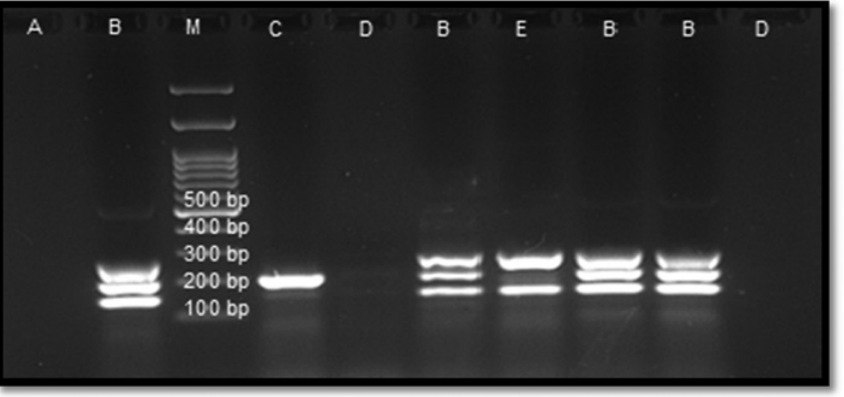
Figure 3: Triplex PCR for phylogenetic groups. Lane A, negative control; lane B, group B2; lane C, group A; lane D, group A; lane E, group D; M, 100 bp